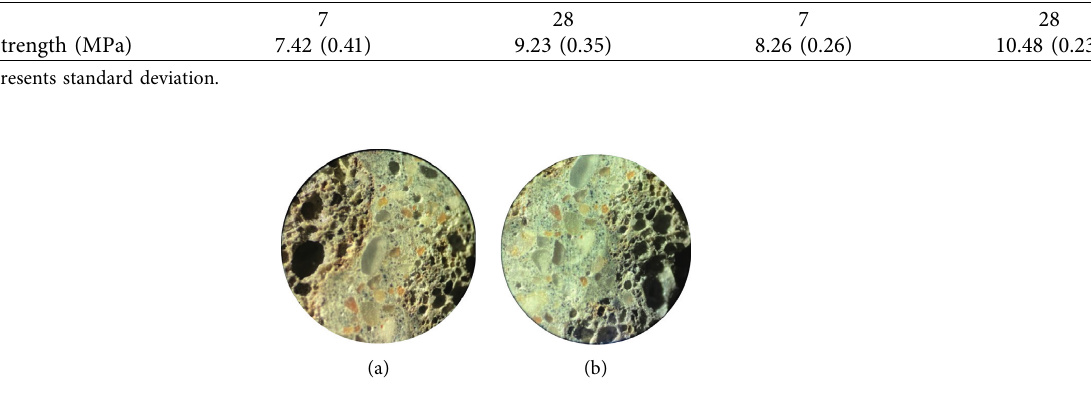
Figure 9: Interlocking of LWA particles. (a) LWAs and (b) LWAr (scale: 10mm